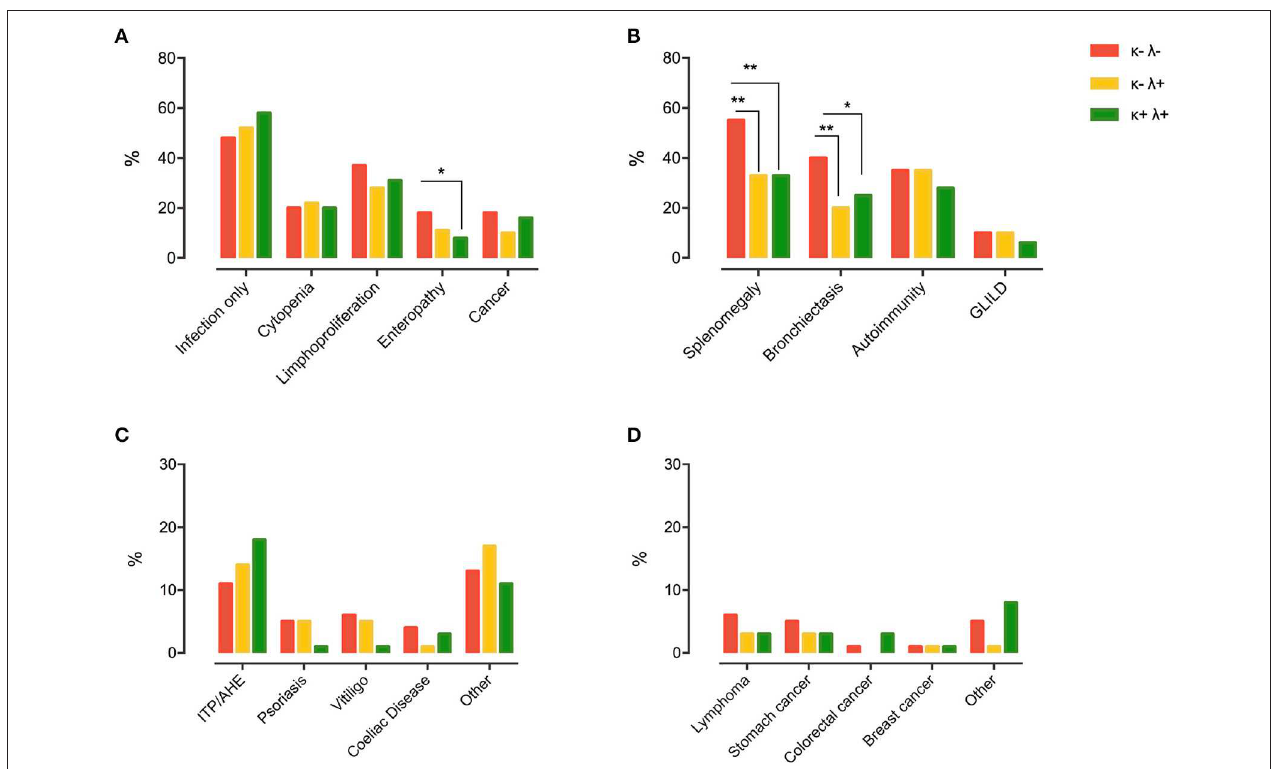
FIGURE 3 | Chapel clinical phenotyping (A) and CVID-related comorbidities (B) in participants grouped by FLC pattern ( κ + λ − group was censored as it was composed of only nine subjects). The most prevalent types of autoimmune diseases and cancers in the different CVID subgroups are detailed in (C,D) , respectively. Levels of significance for comparison by Fisher’s test: * P ≤ 0.05,** P ≤ 0.01. ITP, idiopathic thrombocytopenic purpura; AHE, autoimmune hemolytic anemia; GLILD, granulomatous and lymphocytic interstitial lung